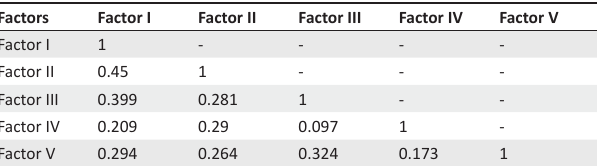
TABLE 10: Factor correlations for rotated factors.